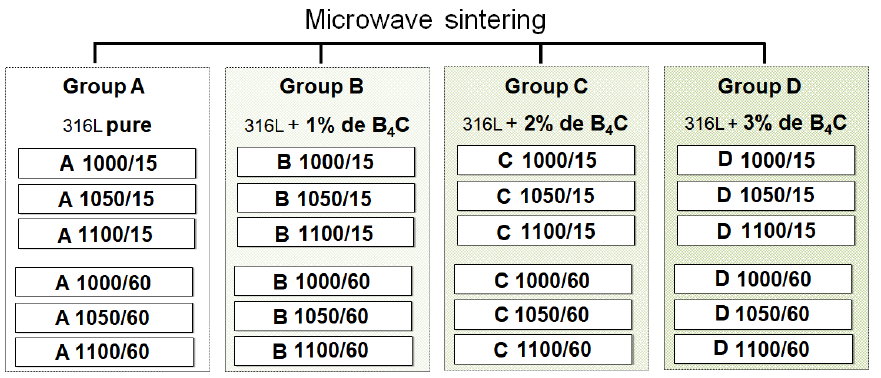
Fig. 1. Sintering parameters adopted in the present study.